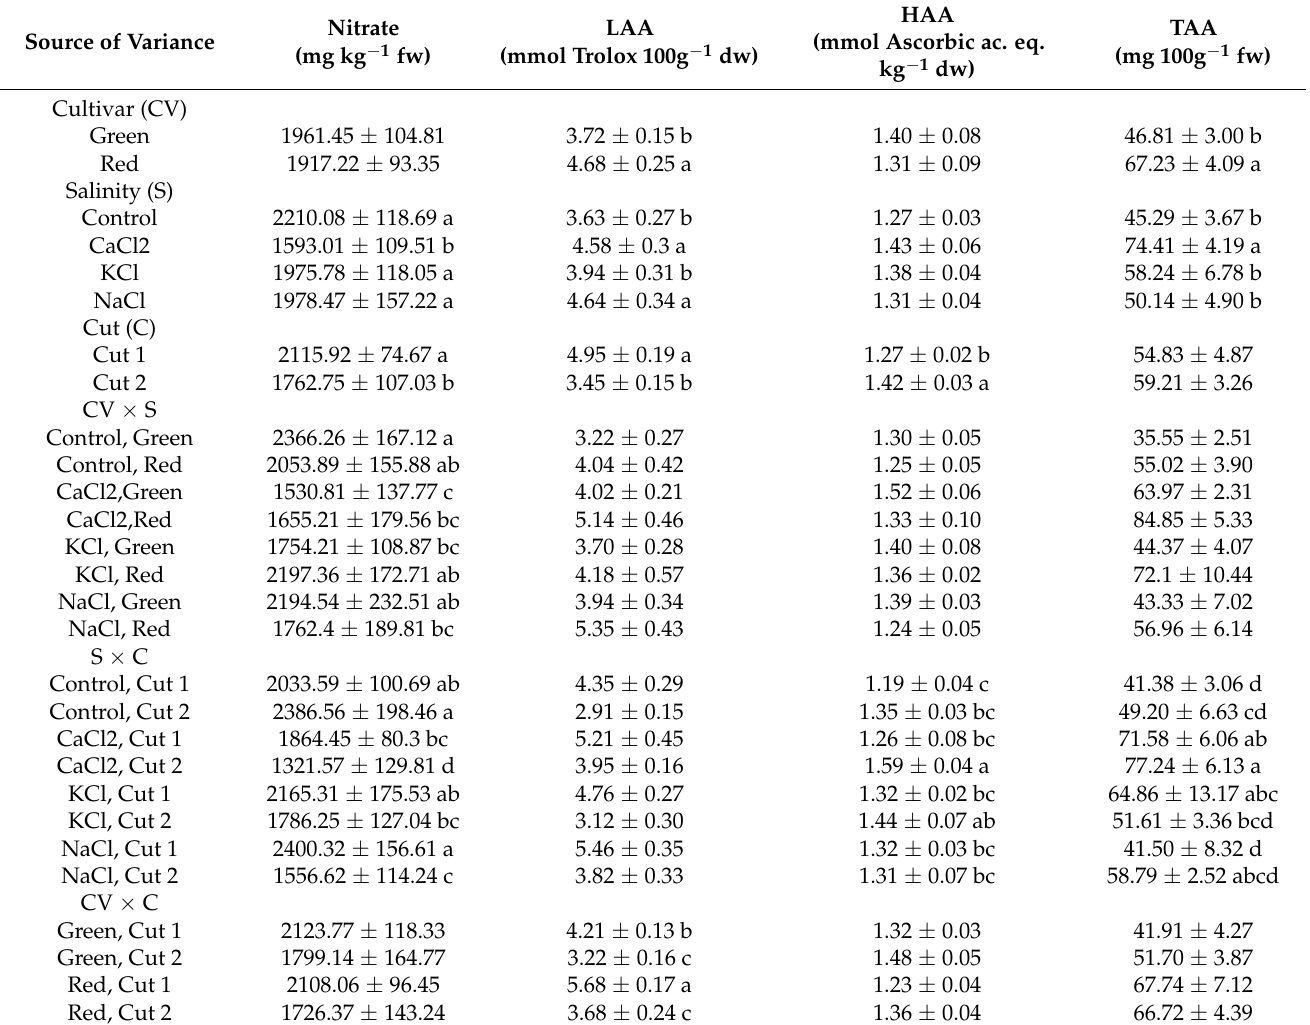
Table 4. Significance of the main factors (cultivar, salinity, and cut order) and their interactions on nitrate content, lipophilic antioxidant activity [LAA], hydrophilic antioxidant activity [HAA], and total ascorbic acid [TAA] of Lactuca sativa L. var. acephala grown in a floating